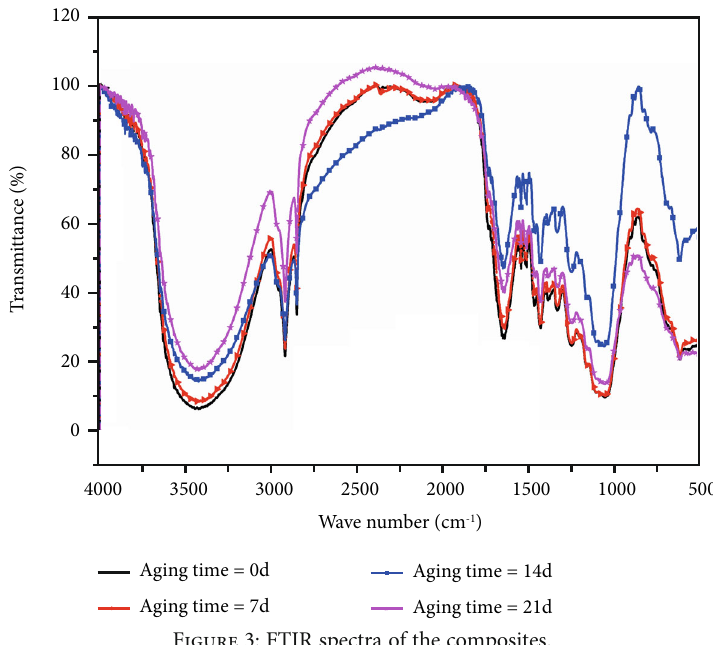
Figure 3: FTIR spectra of the